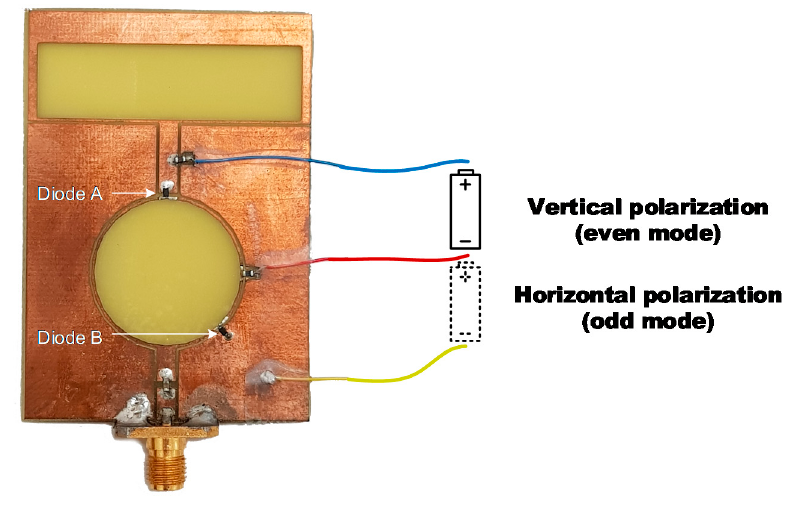
Figure 5. Simulated surface current distribution: ( a ) vertical mode and ( b ) horizontal mode.